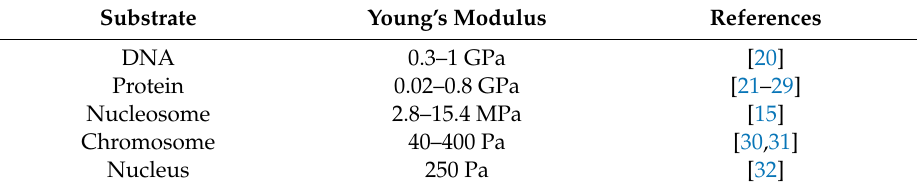
Table 1. The Young’s modulus across single molecules and macromolecules di ff er by orders of